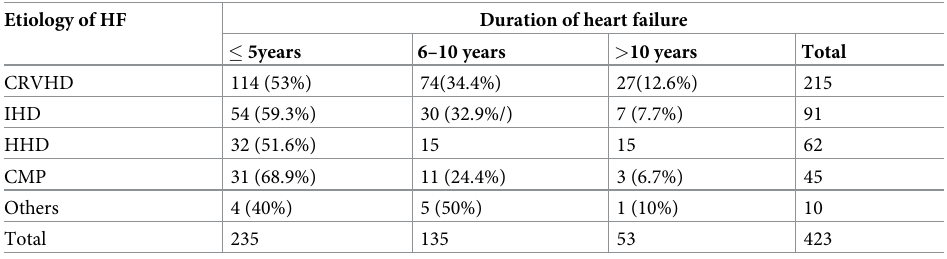
Table 4. Disaggregation of duration of heart failure with etiology among patients attending at the cardiac clinic of Tikur Anbessa Specialized Hospital, Addis Ababa, Ethiopia June—August, 2017.